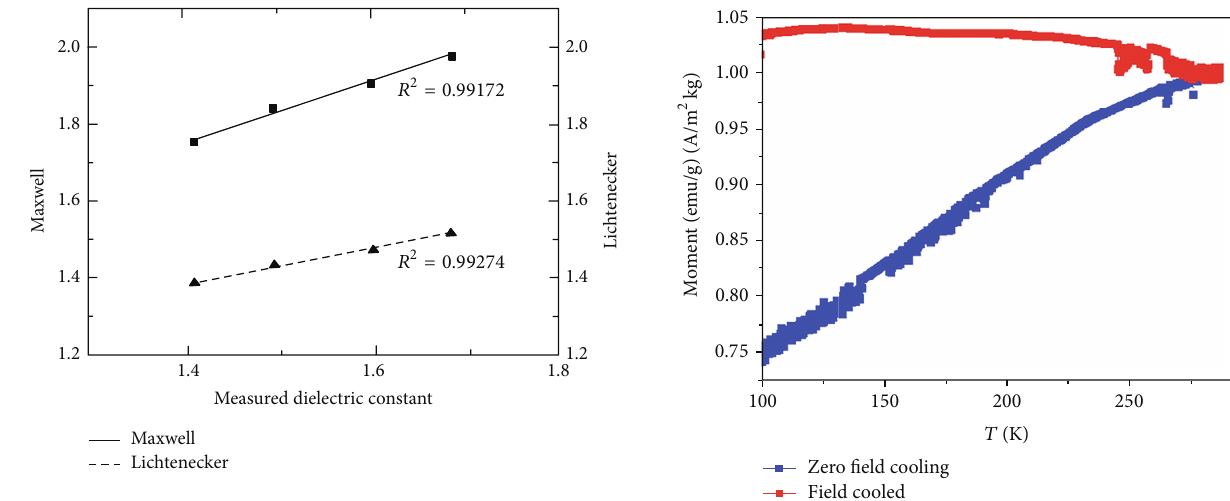
Figure 8: ZFC and FC measurements of PVdF/Fe 3 O 4 (5%) fibre web at 25